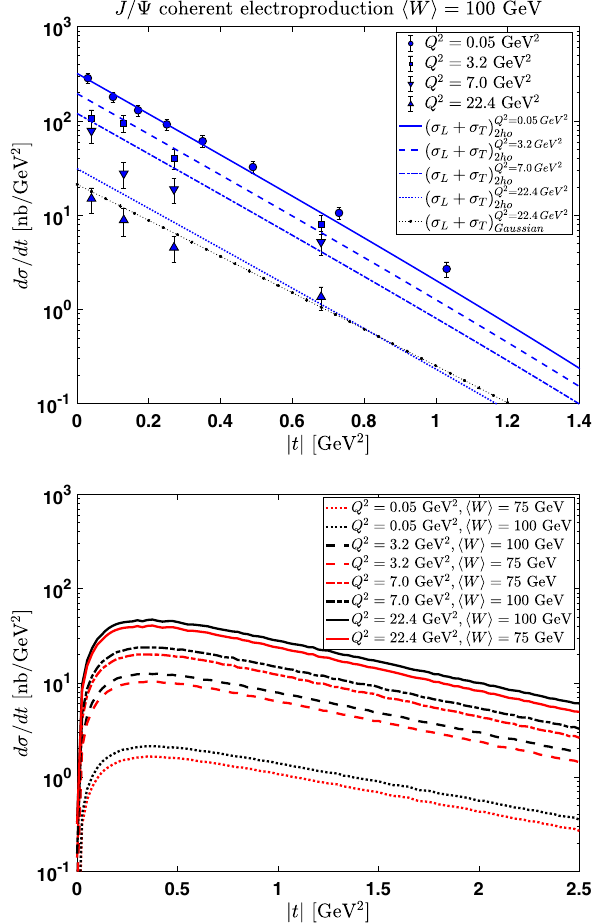
Fig. 11 Upper panel: Coherent differential cross section ( σ L + σ T ) for electroproduction of J /Ψ as a function of the total momentum transfer (square) t . Predictions within the quark-model-based approach (2 h.o.) and related N NLO gluon profile are compared with data from HERA (H1) [16]. For Q 2 = 22 . 4 GeV 2 also the predictions of the Gaussian profile function ( B G = 4 . 0 GeV − 2 ), and the related ( LO ) gluon fit are shown as an example. In the lower panel: the incoherent components of the cross section at different Q 2 and within the QMBA (2 h.o.). The gluon fluctuations are included by using the same gluon distribution around each single quark used for J /Ψ photoproduction ( B q = 0 . 7 GeV − 2